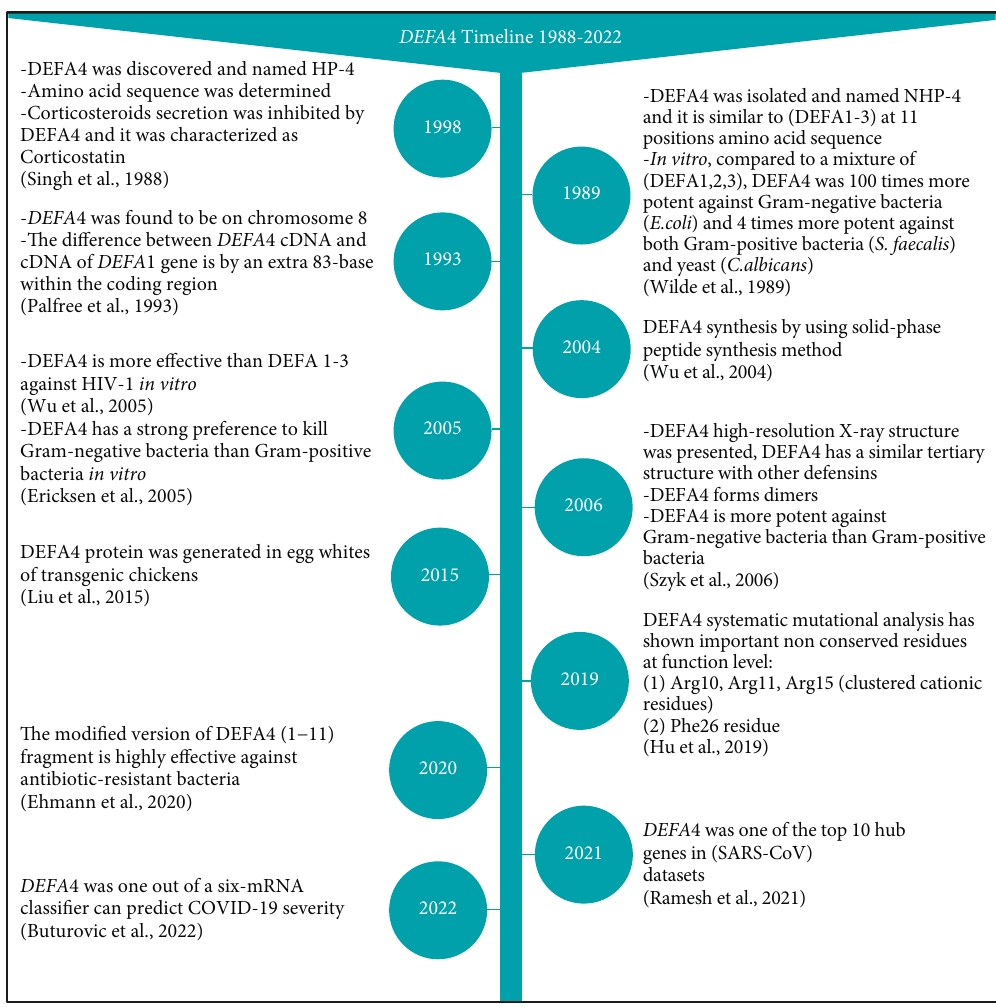
Figure 2: Milestone reports that have contributed to describing DEFA4 properties over the years. Created with BioRender.com.